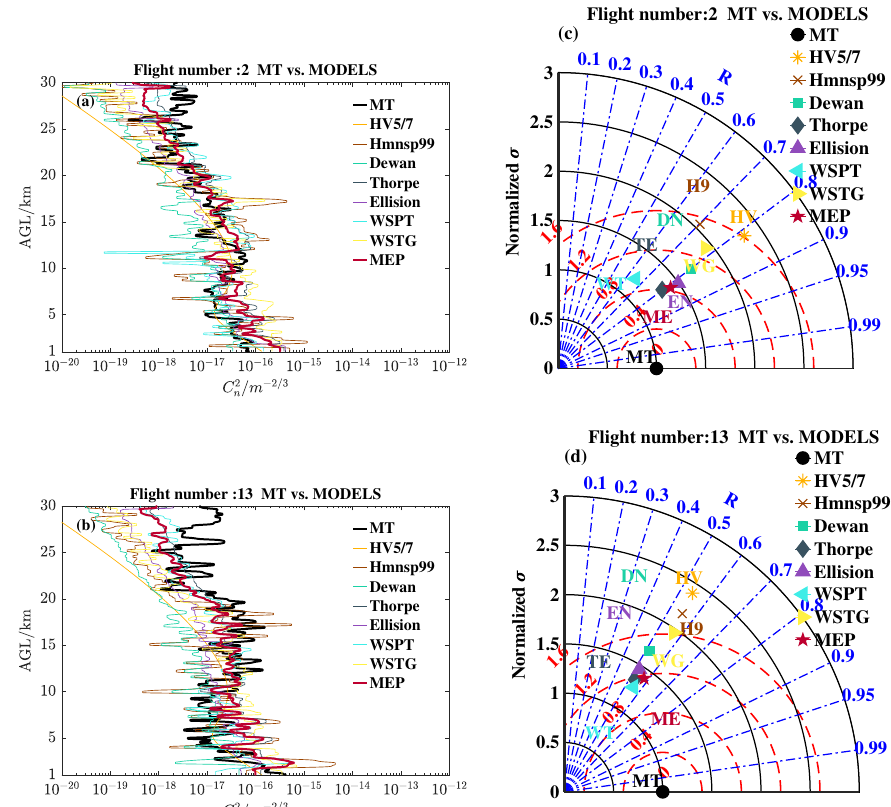
Figure 3. Measured and estimated C 2 n profiles in ECACN. ( a , b ): single day C 2 n profiles; ( c , d ): corre- sponding Taylor diagram of a single day C 2 n statistics. The black solid curves in circles mark MT and models normalized standard deviation ˆ σ ; the blue dashed lines mark the correlation coefficient R ; the red dashed lines mark the root-mean-square difference E (cid:48) between the models and MT. Intuitively, the closer the model is to the reference (MT, the black circle solid point) in the diagram, the better the estimation is.